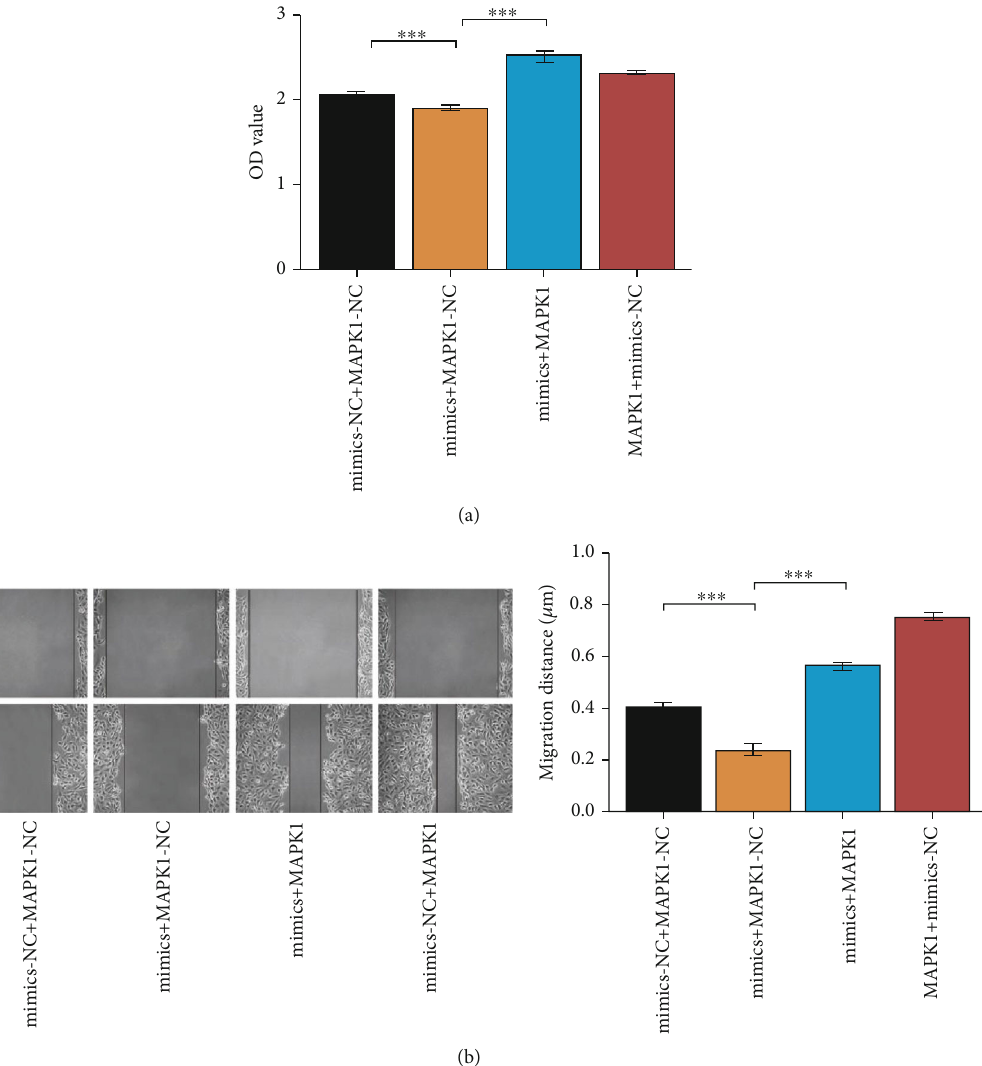
Figure 8: MAPK1 neutralizes the anti fi brogenic e ff ect by miR-450a-2-3p. (a) The proliferation of CFs was quanti fi ed by the CCK8 assay. CFs were transfected with mixture of miR-450a-2-3p mimics or NC (10 μ L) and MAPK1 overexpression plasmid or empty vector (2.5 μ g) for 48h. (b) The scratch test was used to characterize the EMT in HUVECs. HUVECs were treated with blend of miR-450a-2-3p mimics or NC (10 μ L) and MAPK1 overexpression plasmid or empty vector (2.5 μ g) for 24h. Data is presented as the mean ± SEM of three